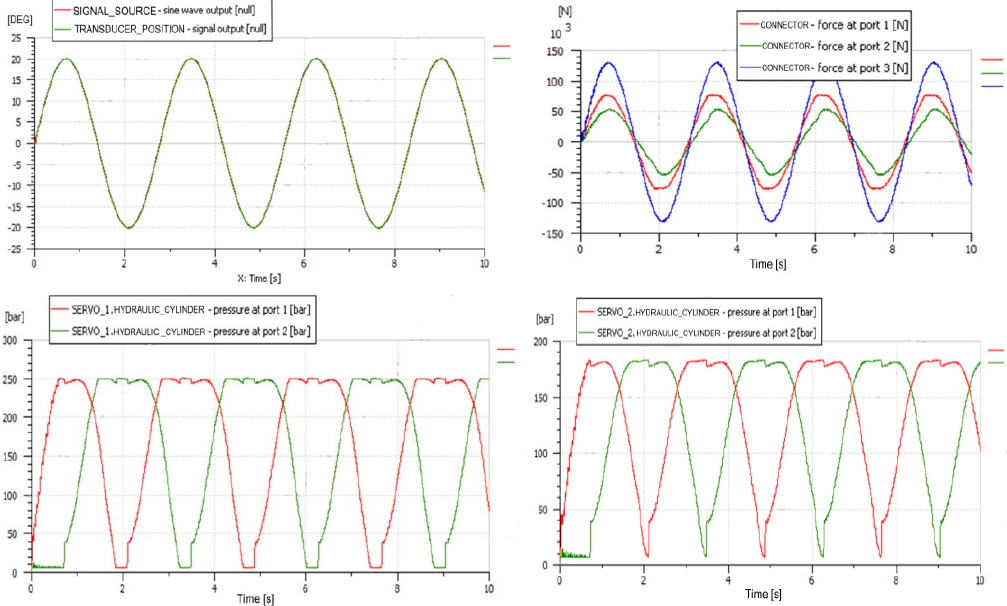
Figure 4. System behavior for a sinusoidal signal with a frequency of 0.36 Hz and an amplitude of 20°.